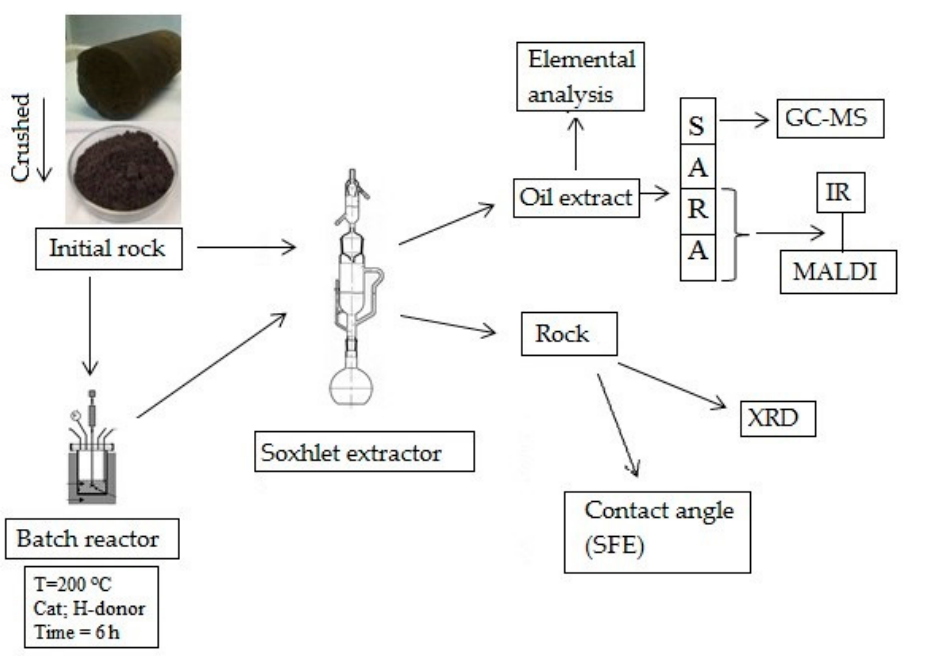
Figure 1. Scheme of the experiment.